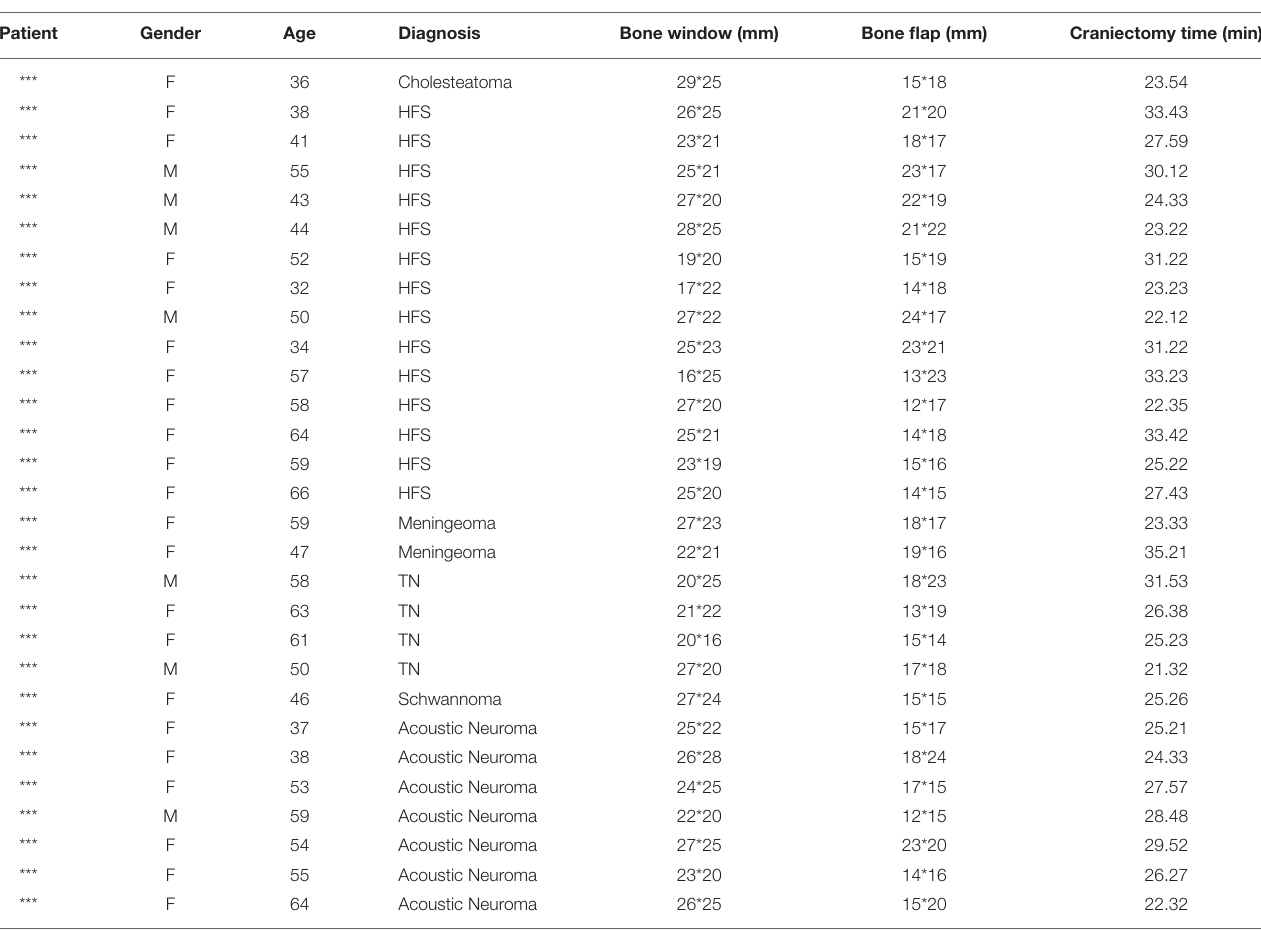
TABLE 2 | Clinical data for the 29 enrolled